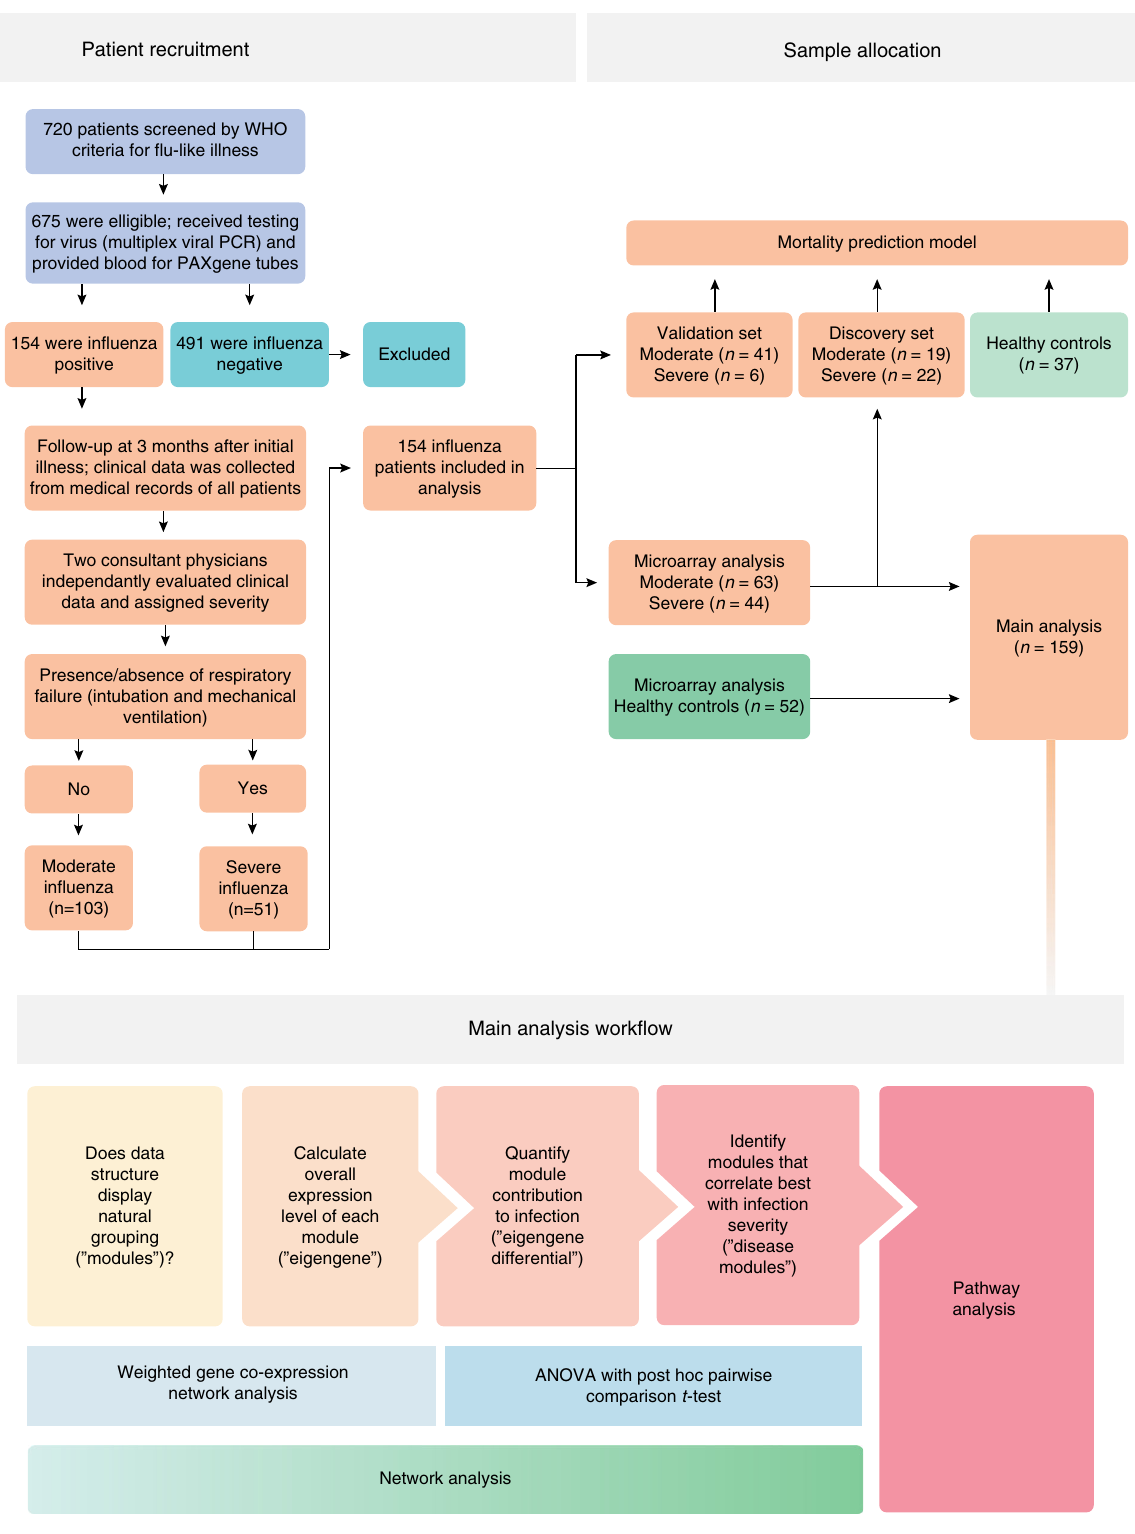
Fig. 1 Study scheme. Flow chart shows patient recruitment, sample allocation, and analysis work fl